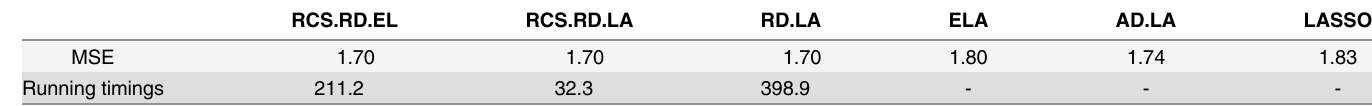
Table 3. Average of root mean squared errors of 99 regression models and average of running timings (unit: minute).